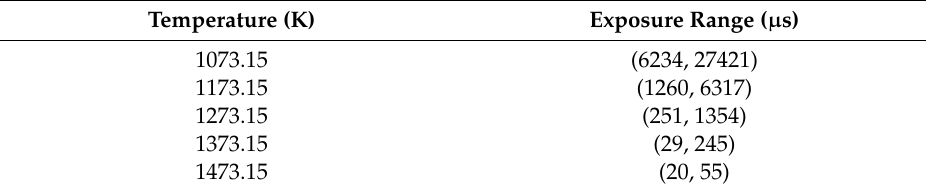
Table 1. Reasonable exposure ranges for different furnace temperatures.